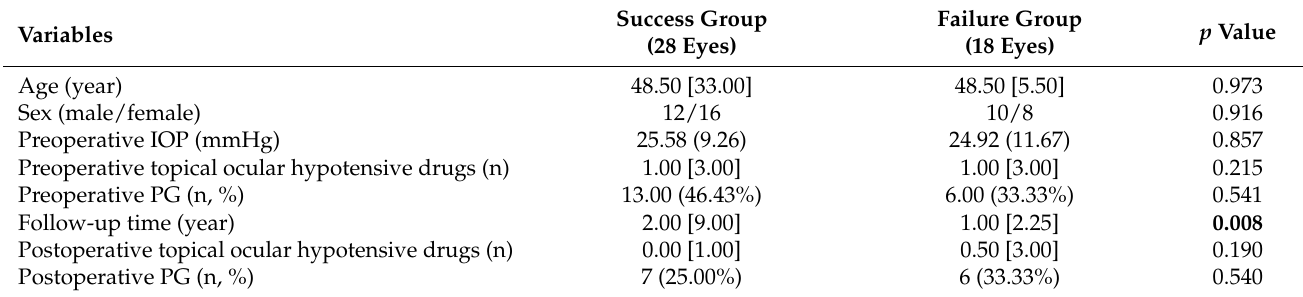
Table 1. Demographic and baseline characteristics of study subjects.